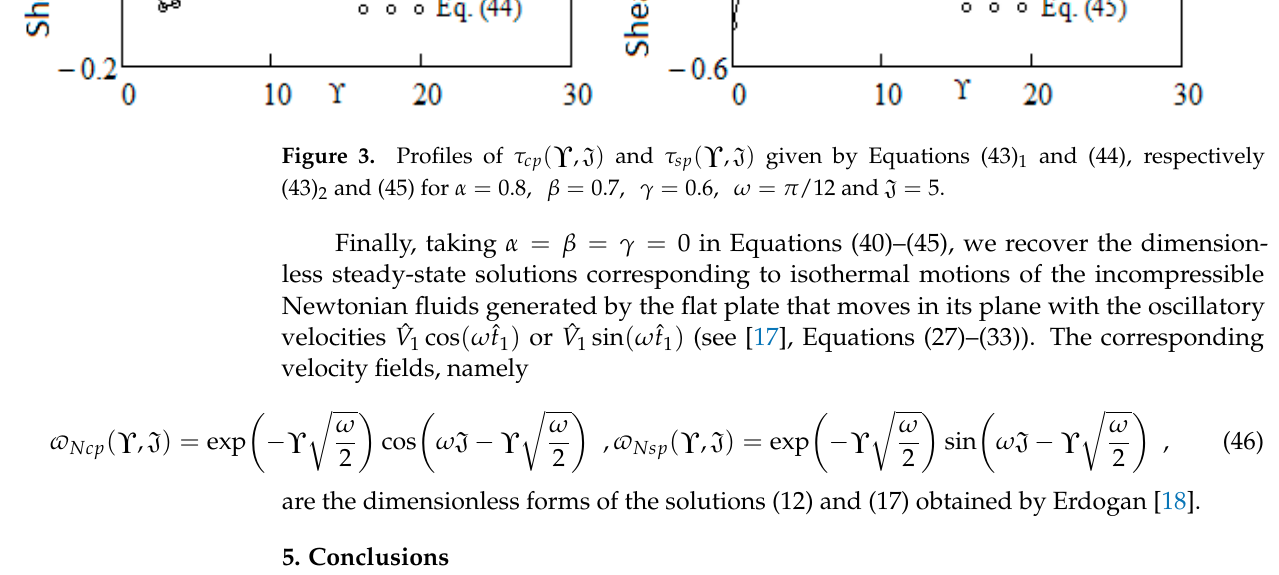
The boundary conditions (17) and (18) and the fact that the fluid was at rest at the ℑ = , tell us that the two unsteady motions become permanent or steady initial moment 0 in time. An important problem for such motions is to know the need time to reach the permanent or steady state. To determine this time, exact expressions have to be known for the transient or steady-state components of starting solutions. Unfortunately, there is